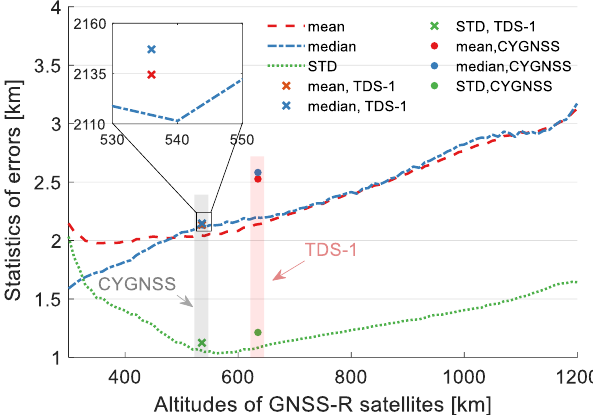
Figure A4. Statistics of empirical specular point estimation errors corresponding to different orbit height situations. The radius of the Earth sphere is 6378 km, and the fixed height of the transmitter is 20,200 km. A quantity of 900,000 and 320,000 events (only GPS) from the TDS-1(cross dots) and CYGNSS (circular dots) satellites are also used to validate this empirical model, respectively.